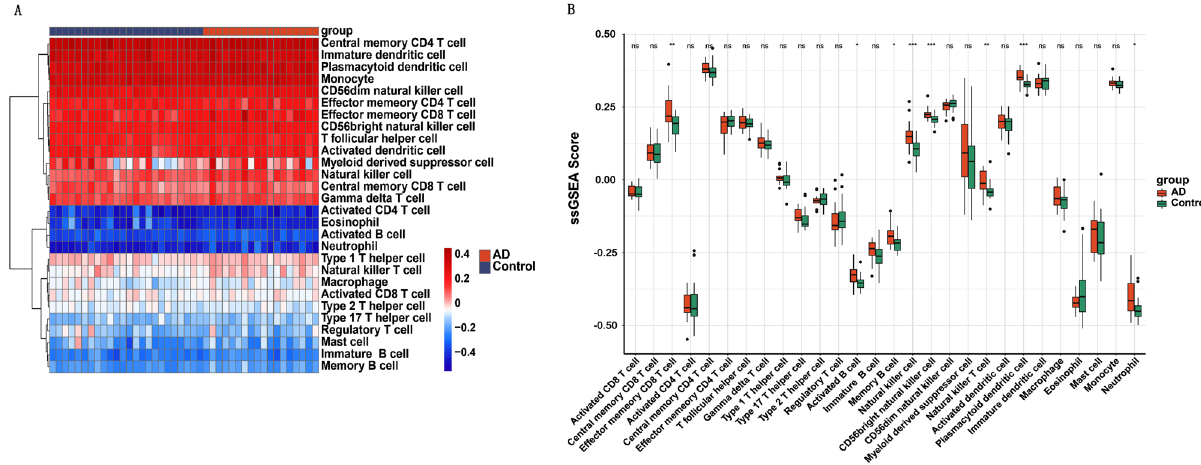
Figure 3. ( A ) Heatmap showing the distribution of 28 infiltrating immune cells in AD and normal samples. ( B ) ssGSEA analysis of immune infiltration of 28 immune